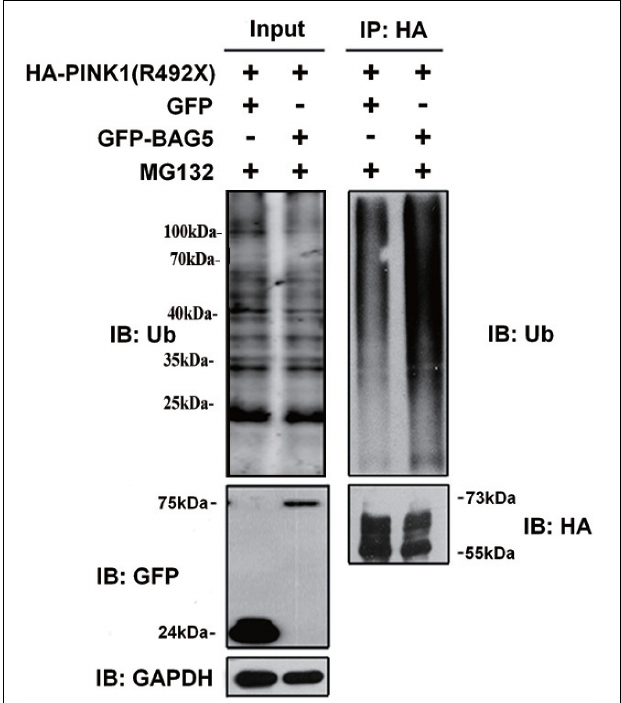
FIGURE 4 | BAG5 increases ubiquitination of R492X mutated PINK1 protein. HEK293 cells were co-transfected with HA-PINK1 R492X and EGFP-N1 or EGFP-BAG5. The cells were treated with 10 mM MG132 for 12 h and subjected to immunoprecipitation using rabbit polyclonal antibodies against HA tag. Inputs and immunoprecipitants were subjected to immunoblot analysis using anti-ubiquitin, anti-EGFP, anti-HA tag or anti-GAPDH